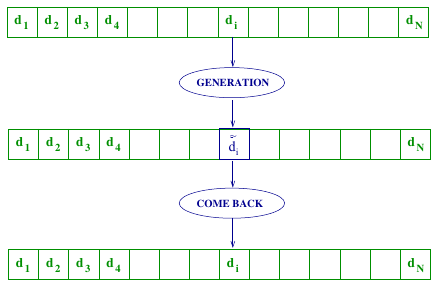
Figure 4. Optimization of the generation process. In this figure, the state space is built with a vector of decision for which the generation process consists in changing only one decision ( d i ) in the current solution. If this generation is not accepted, this component of the solution recovers its former value. The only information to be stored is the integer i and the real number d i